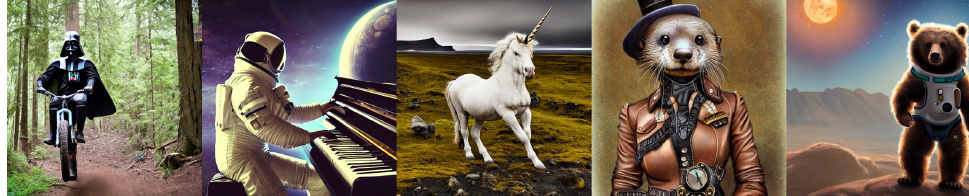
Figure 13. Example of Stable Diffusion